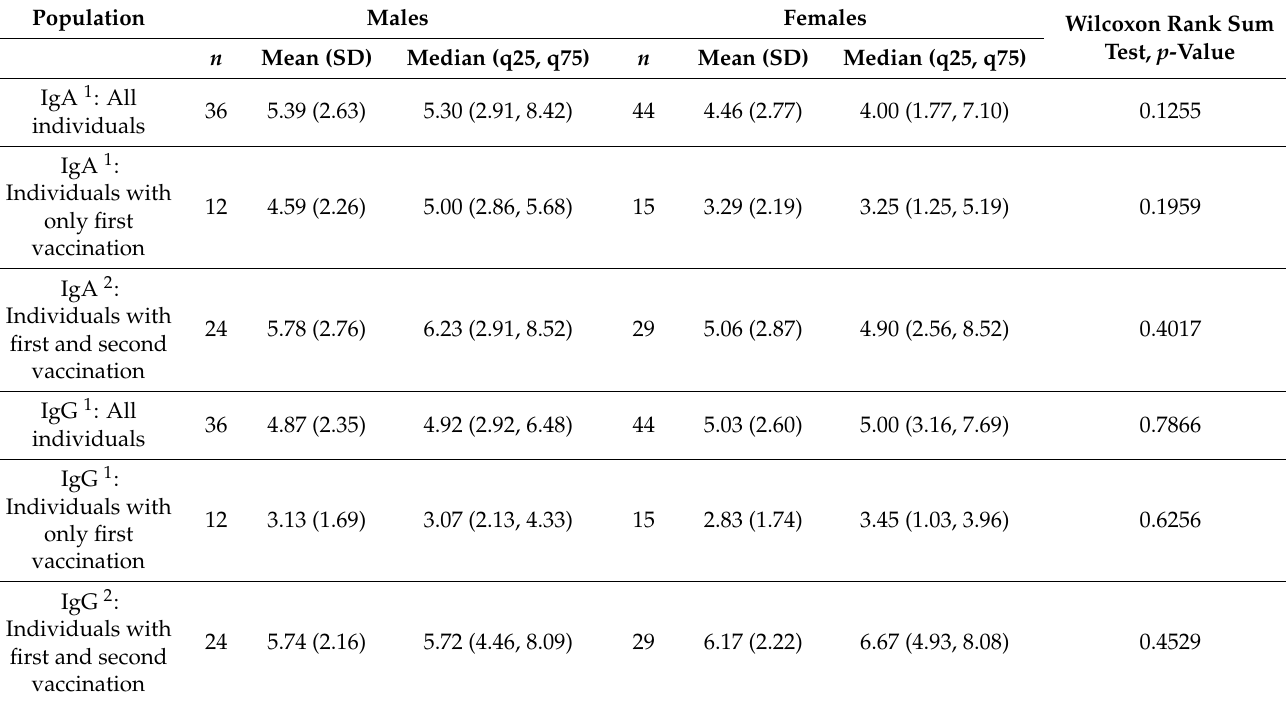
Table 3. Comparison of spike protein antibody titers among males and females applying Wilcoxon’s rank sum